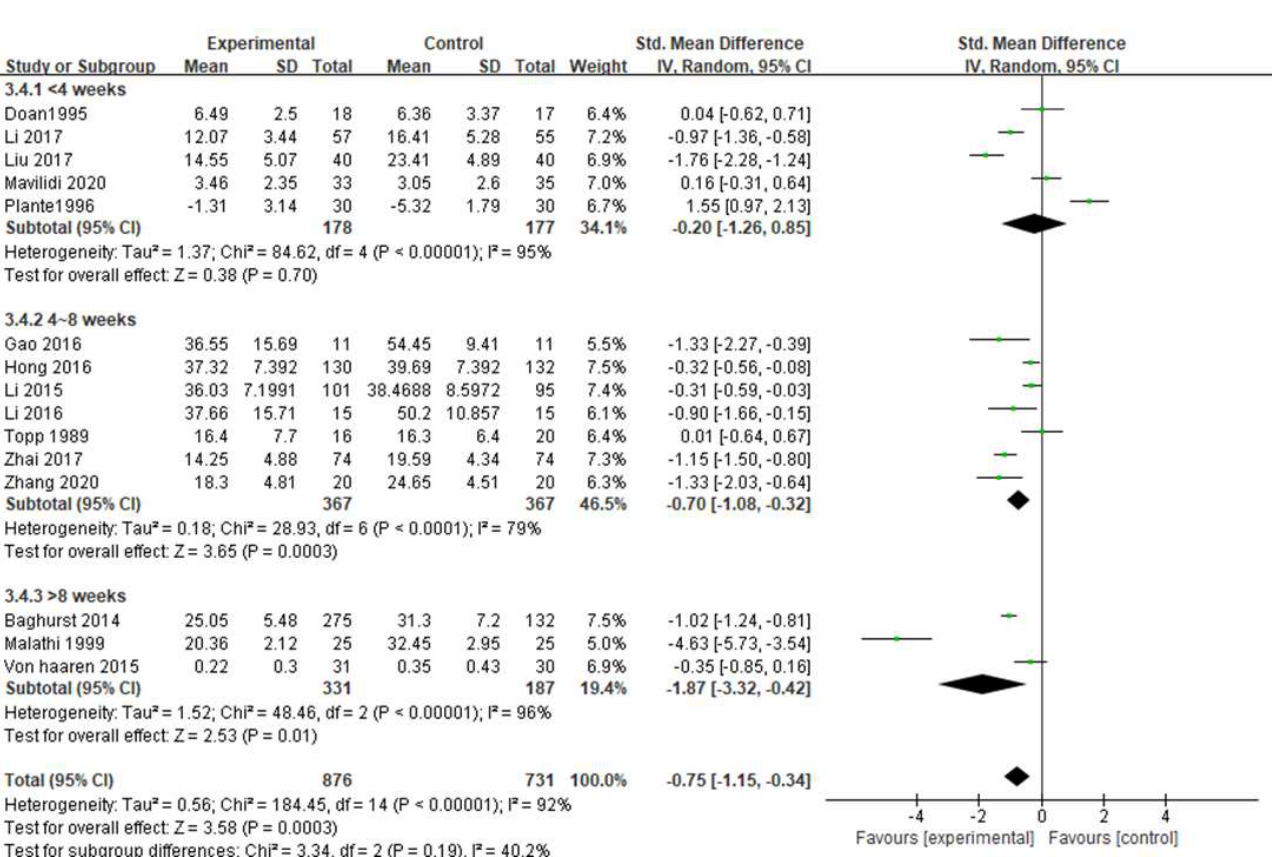
Figure 9. Subgroup analysis of intervention period